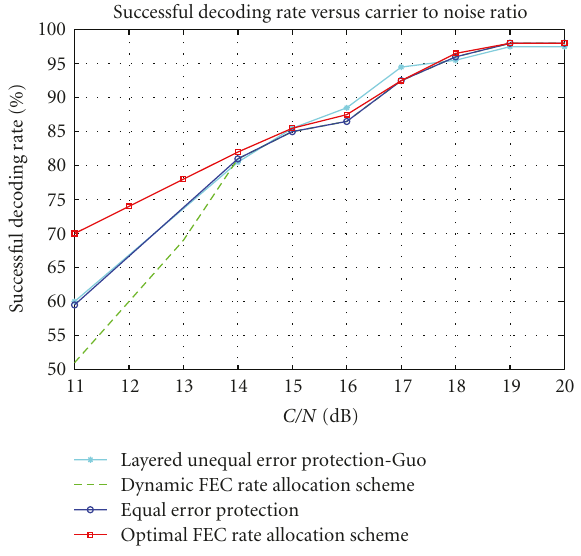
Figure 13: Successful decoding rate.